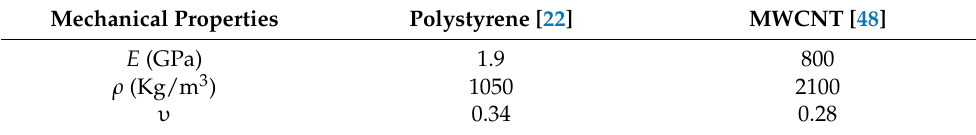
(cid:113) ρ ( 1 − υ 2 ) ) of the cylindrical shell for the C-C E